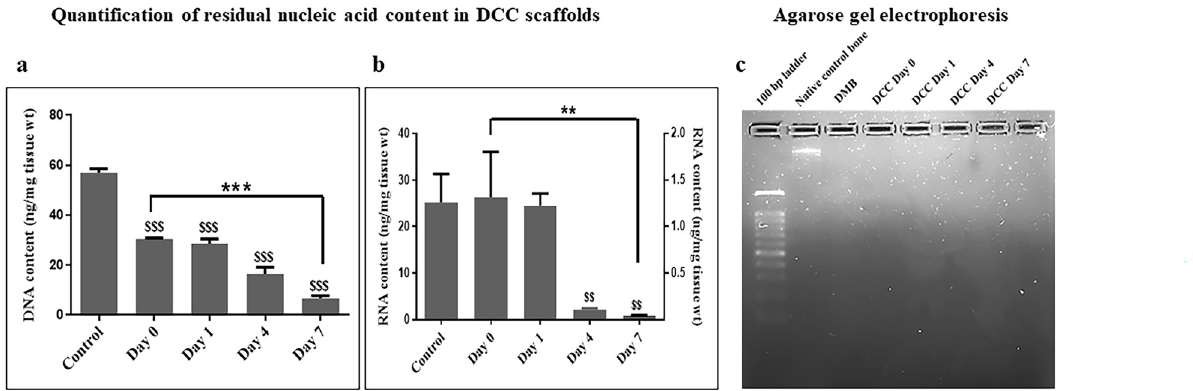
Fig 6. Quantification of the total nucleic acids in DCC scaffolds. The amount of residual DNA (a) and RNA (b) in the DCC scaffolds compared to native control bone and processed bone samples without DNase/RNase exposure; signifies day 0 is shown. Total residual DNA and RNA obtained were normalized by the dry weight of each bone sample and interpreted. Values are expressed as mean ± SEM (n = 6). Statistically significant differences of *** p < 0.001, ** p < 0.01, $$$ p < 0.05 and $$ p < 0.0001 are indicated. (c) Agarose gel electrophoresis image of the total DNA extracted from DMB scaffold, DCC without exposure to DNase/RNase (day 0) and on days 1, 4, and 7 post-DNase treatment of DCC scaffolds compared to native control